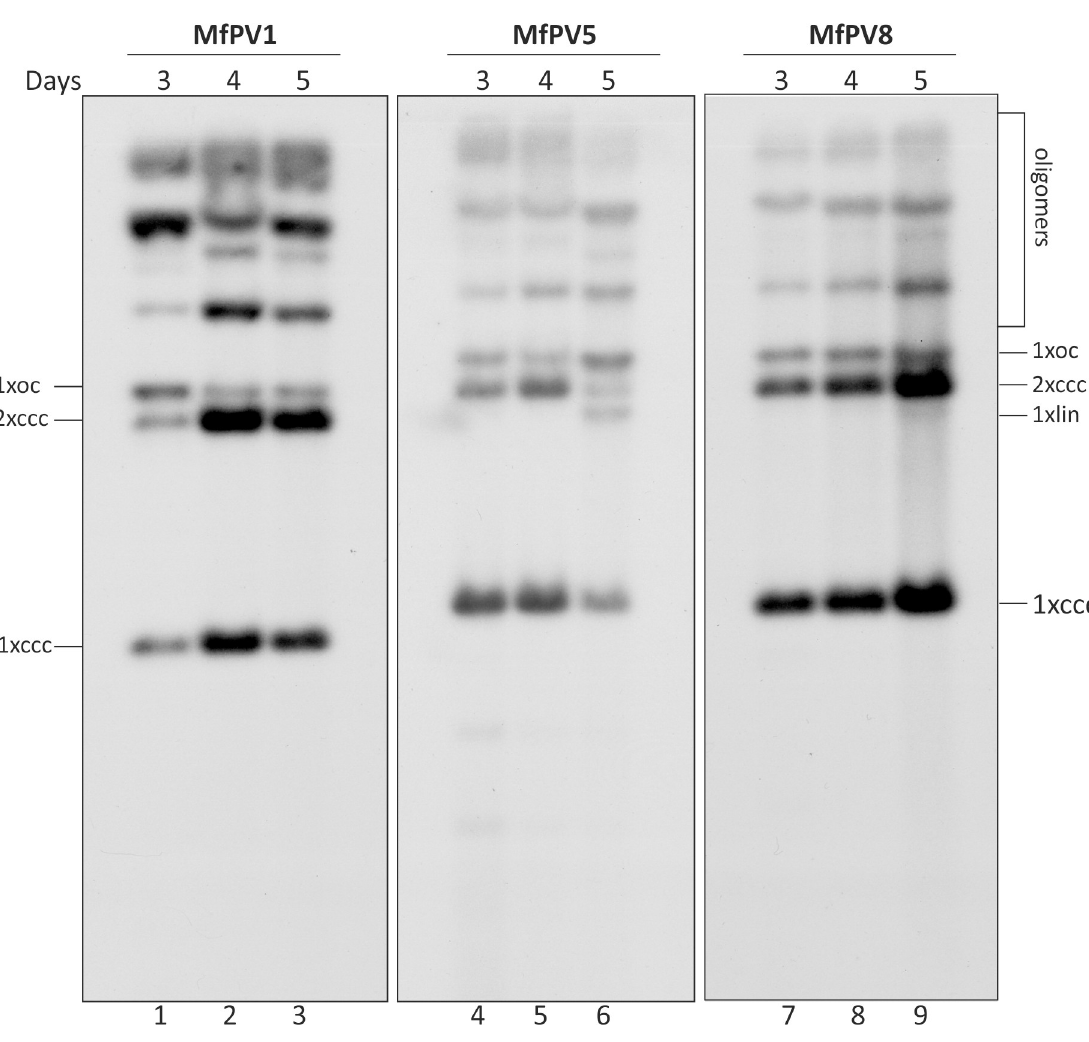
Fig 3. The physical state of the MfPV genomes during transient DNA replication in U2OS cells. U2OS cells were transfected with 4 μ g E8^E2C mutant minicircle DNA of MfPV1 (lanes 1–3), MfPV5 (lanes 4–6), and MfPV8 (lanes 7–9). LMW DNA extracted via Hirt lysis 3, 4 and 5 days posttransfection (shown on the top), the samples were treated with DpnI, and analyzed by Southern blotting. Abbreviations: oc, open circular molecules; ccc, covalently closed circular molecules; lin, linear molecules; the numbers 1 and 2 refer to monomers and dimers,